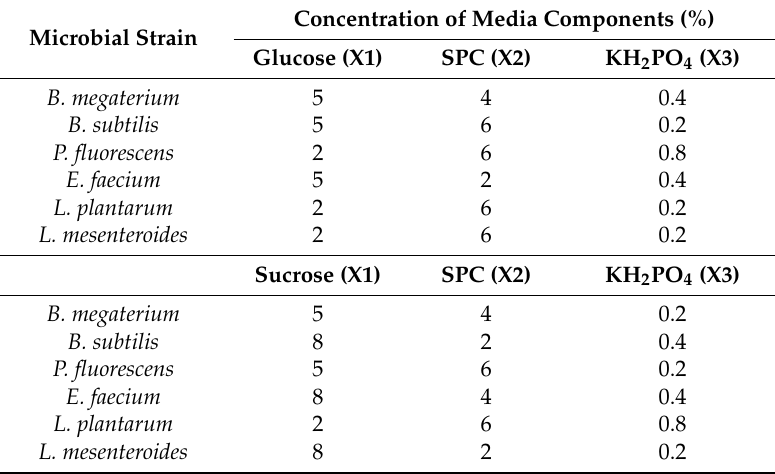
Table 3. Final optimized concentrations of culture media components based on Taguchi